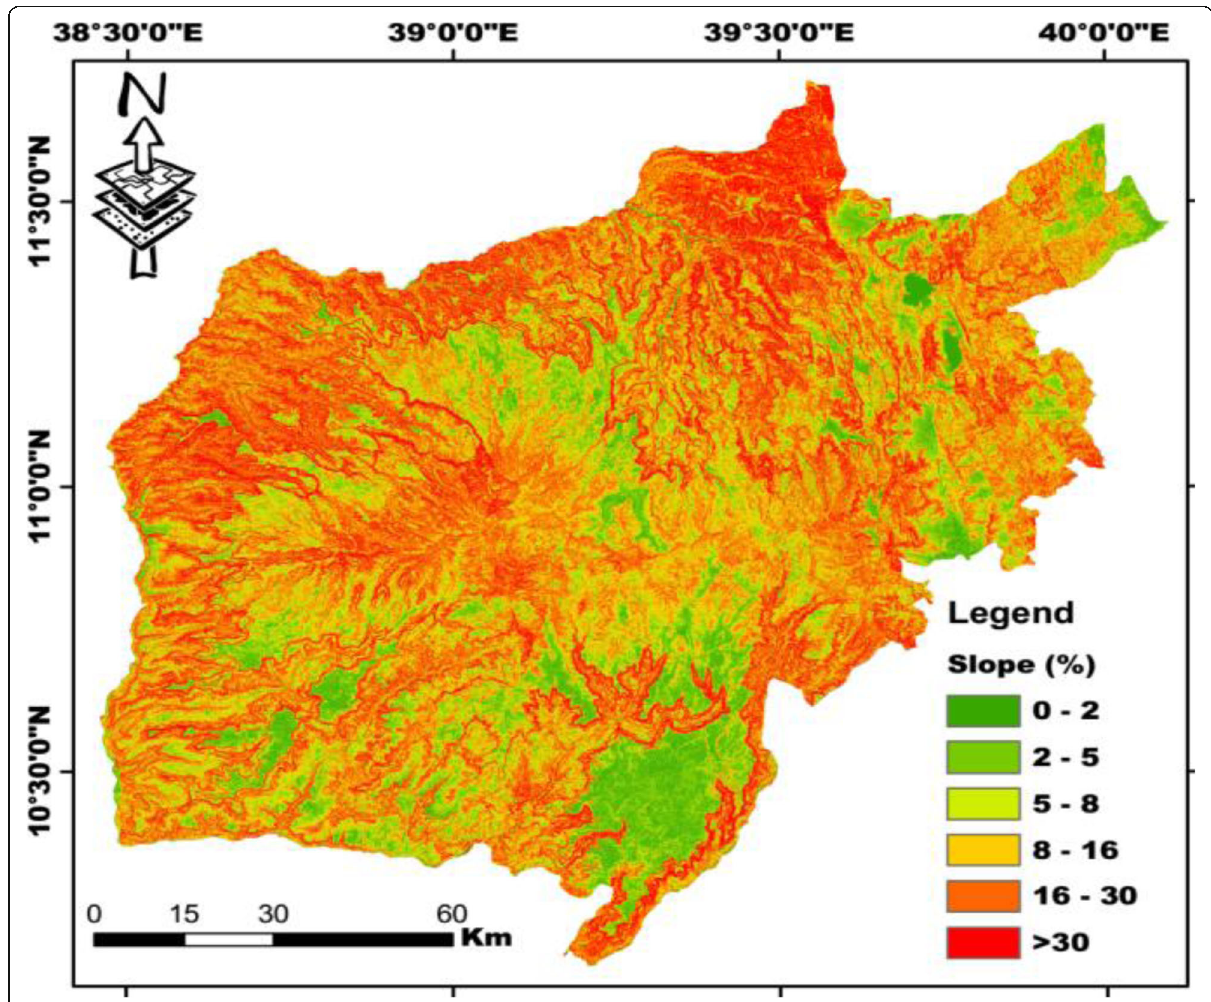
Fig. 6 The slope type classification and their spatial pattern of South Wollo administrative